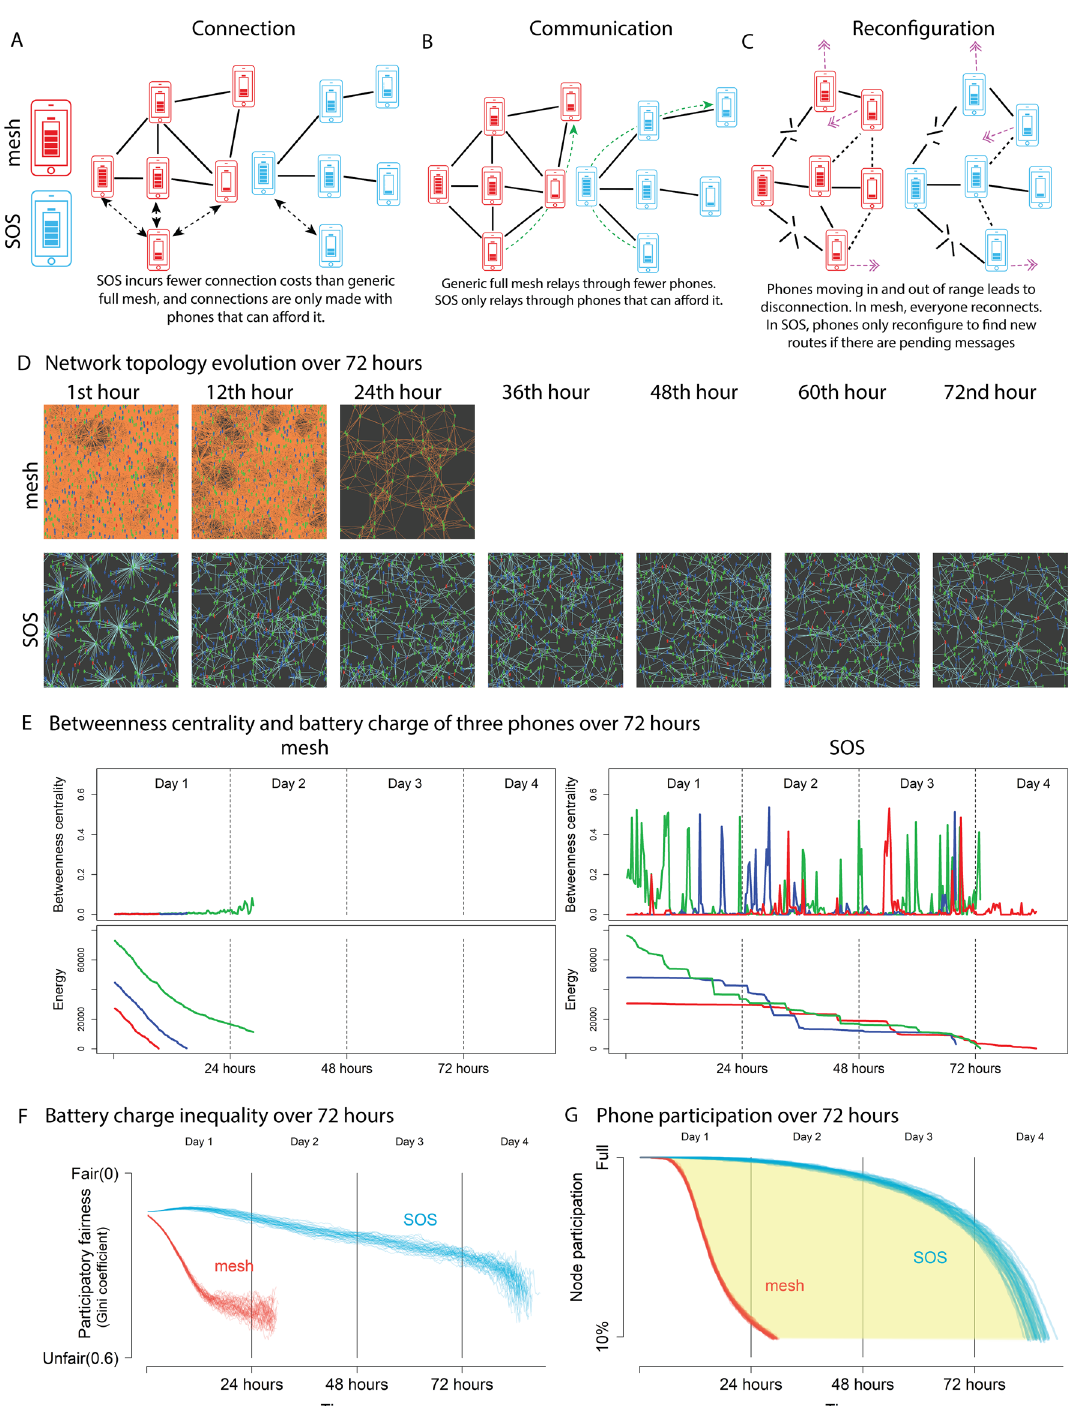
Figure 1. ( A ) Differences in connection, ( B ) communication and ( C ) reconfiguration patterns between a generic mesh protocol (red) and SOS (blue). ( D )–( G ) Results of simulations with 500 phones, sending and receiving 1 message per phone every 15 min for the generic mesh and SOS protocols. ( D ) Formation and evolution of the mesh (top) and SOS topology (bottom). The ad hoc mesh network runs just longer than a day. SOS runs for the entire duration of 72 h. ( E ) Development of Battery charge (Energy) and Betweenness Centrality for a selection of three typical phones (red: low initial battery charge; blue: average initial battery charge; green: high initial battery charge) Left: mesh network; right: SOS. In the mesh network, every phone has the same Betweenness Centrality. In SOS, the Betweenness Centrality fluctuates, with green starting as a central hub; a role which is later taken over by blue and then red, as the relative battery charge changes. This ensures that all phones can equally participate in communication for an extended time period. ( F ) Development of battery charge inequality (Gini coefficient 52 ) over 72 h for the mesh network (red) and for SOS (blue). ( G ) Phone participation over 72 h for the mesh network (red) and for SOS